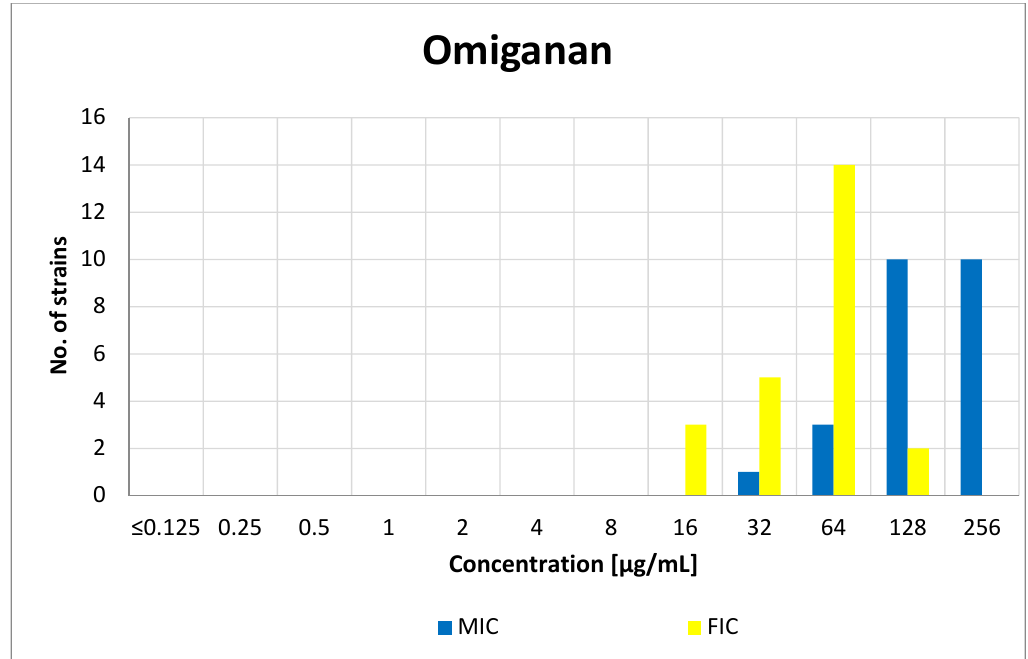
Figure 4. Distribution of the minimum inhibitory concentrations (MICs) of Omiganan and its concentrations at the lowest FIC that indicate synergy or addition (FIC).